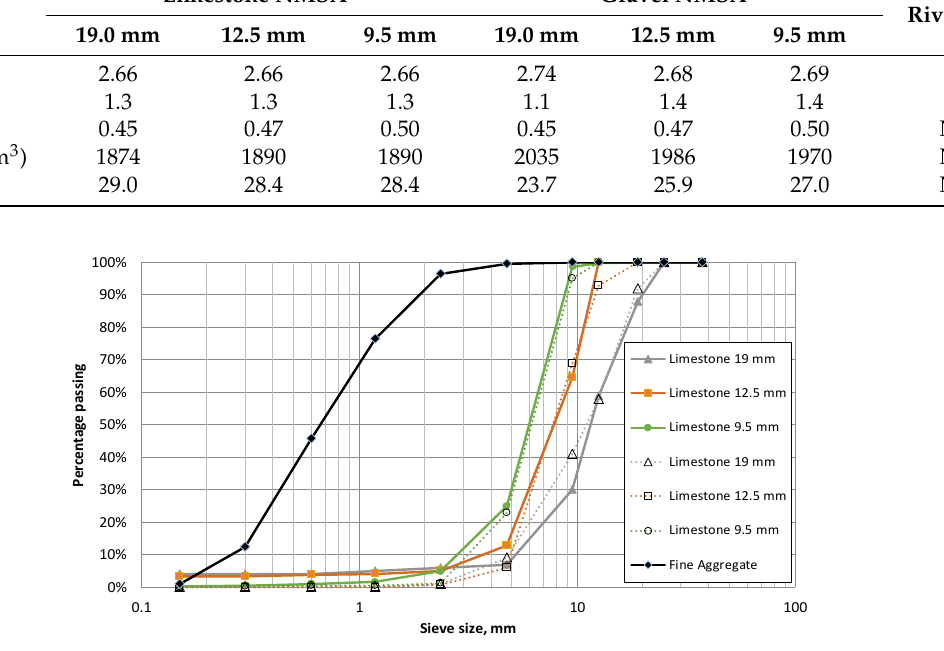
Figure 2. Particle size distribution of fine and coarse aggregates (25 mm = 1 in.). Table 3. Combined aggregate gradations (25 mm = 1